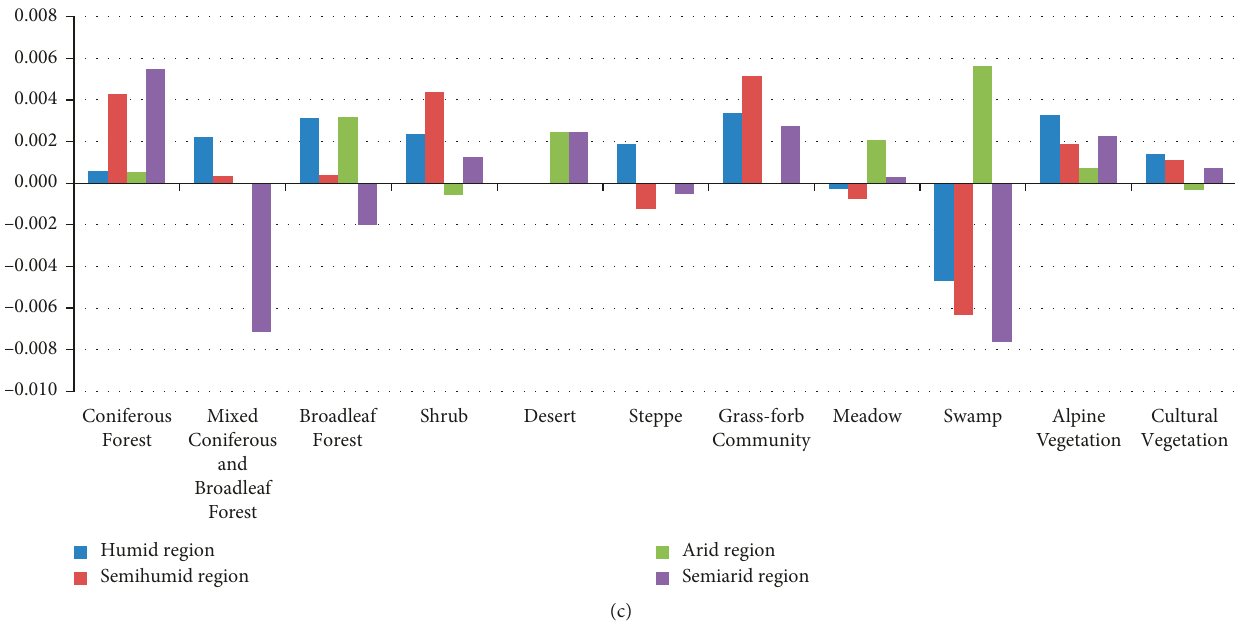
Figure 7: Statistical central tendency of the same vegetation type’s PUEs among climate zones from 2000 to 2015: (a) mean values; (b) standard variations; (c) linear